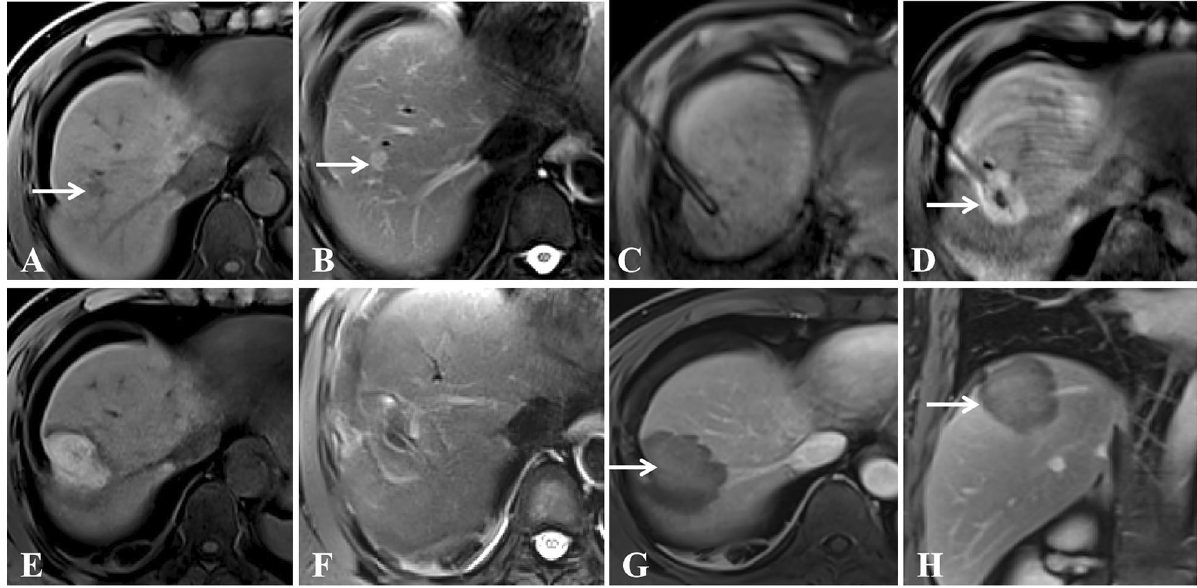
Figure 4. A 54-year-old woman with liver metastasis at segment 8 (primary diagnosis was pancreatic carcinoma). ( A , B ) Pretreatment MR showed a small lesion (diameter = 1.1 cm) on T1WI ( A ) and T2WI ( B ); ( C ) The lesion was punctured by a microwave applicator on T1WI; ( D ) The high signal covered the primary tumor after the first circle of microwave ablation (white arrow); ( E , F ) Posttreatment MR showed that the ablation zone had a high signal on T1WI ( E ) and a low signal on T2WI ( F ); ( G , H ) Enhanced MR showed that the focus was completely ablated at the 1-month evaluation in cross ( G ) and sagittal sections ( H ) (white arrow).